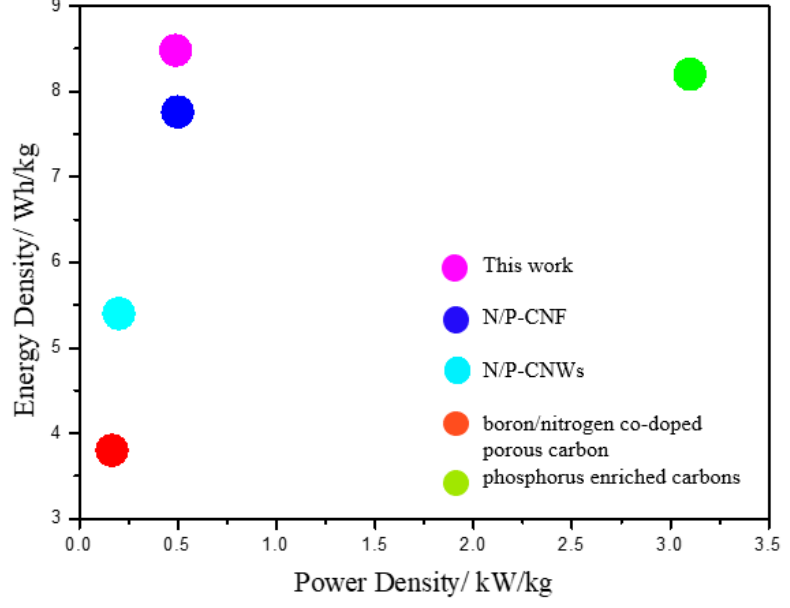
Figure 10. Comparision of the N/P/S-PBC surpercapacitor with other heteroatom-doped carbon-based surpercapacitor [20,28,37,39].